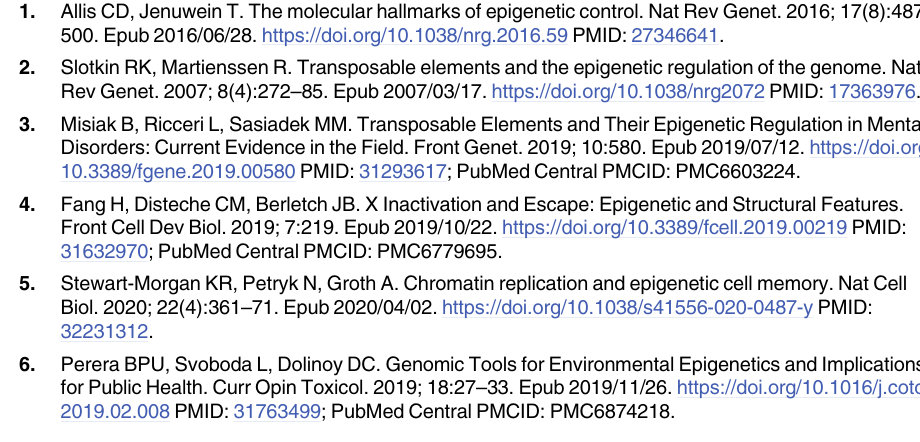
S1 Table. Primers sequences. S2 Table. Mechanisms of action of analyzed epigenic modulators. S3 Table. IC10 of analyzed epigenetic